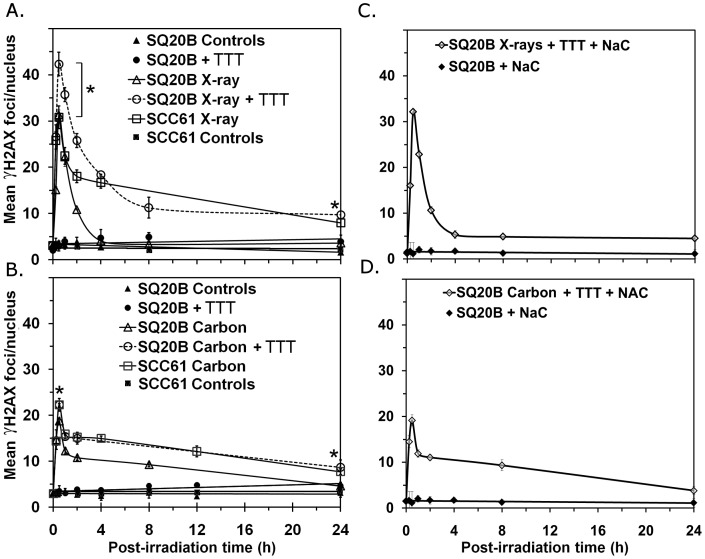
Kinetics of γH2AX foci.Cells were irradiated with 2 Gy of X-rays (A, C) or 1 Gy of carbon ions (B, D). ▴ SQ20B cells, ▵ SQ20B+irradiation, • SQ20B+GSH depletion, • SQ20B+GSH depletion+irradiation, □ SCC61+irradiation. In panels C and D, the reverse effect of N-acetyl cysteine in the presence of DMF/BSO treatment was assayed. One hundred cells were scored for each time and the measurements were made in triplicate and repeated three times. *P<0.05.